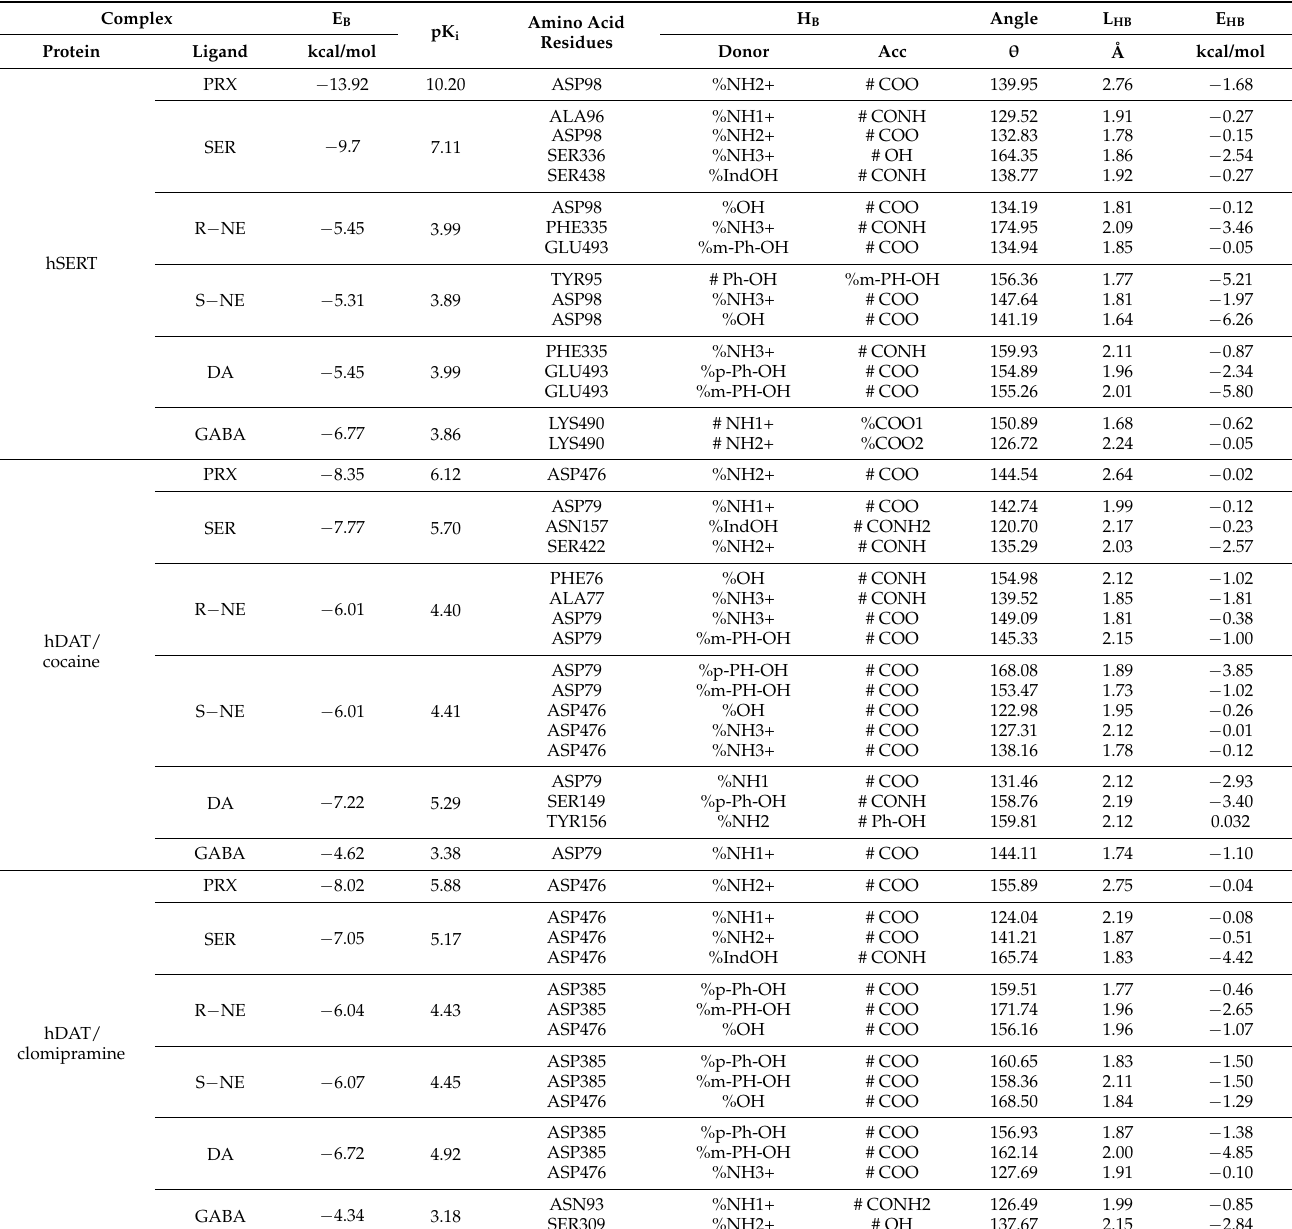
Table 1. The summary of hSERT, hDAT, hNET, hGAT1 and PRX, neurotransmitters docking experiment